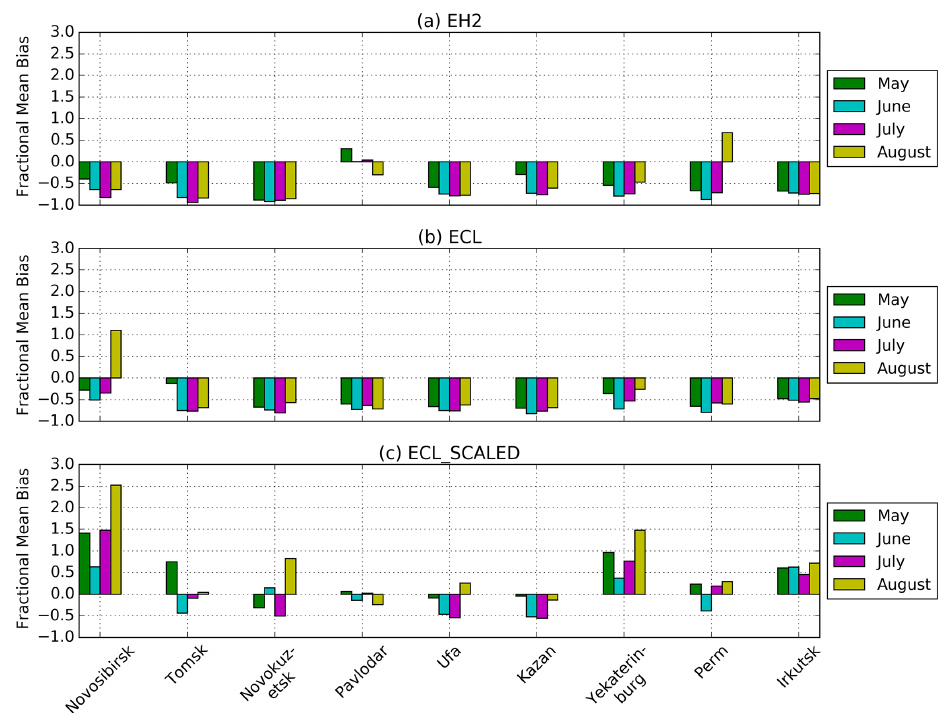
Figure 5. Fractional mean bias of monthly simulated tropospheric column NO 2 for major cities (population > 100000) within western Siberia when compared with OMI values. Panel (a) shows results using the EH2 anthropogenic emission inventory. Panel (b) shows results using the ECL anthropogenic emission inventory. Panel (c) shows results using the ECL_SCALED anthropogenic emission inventory.